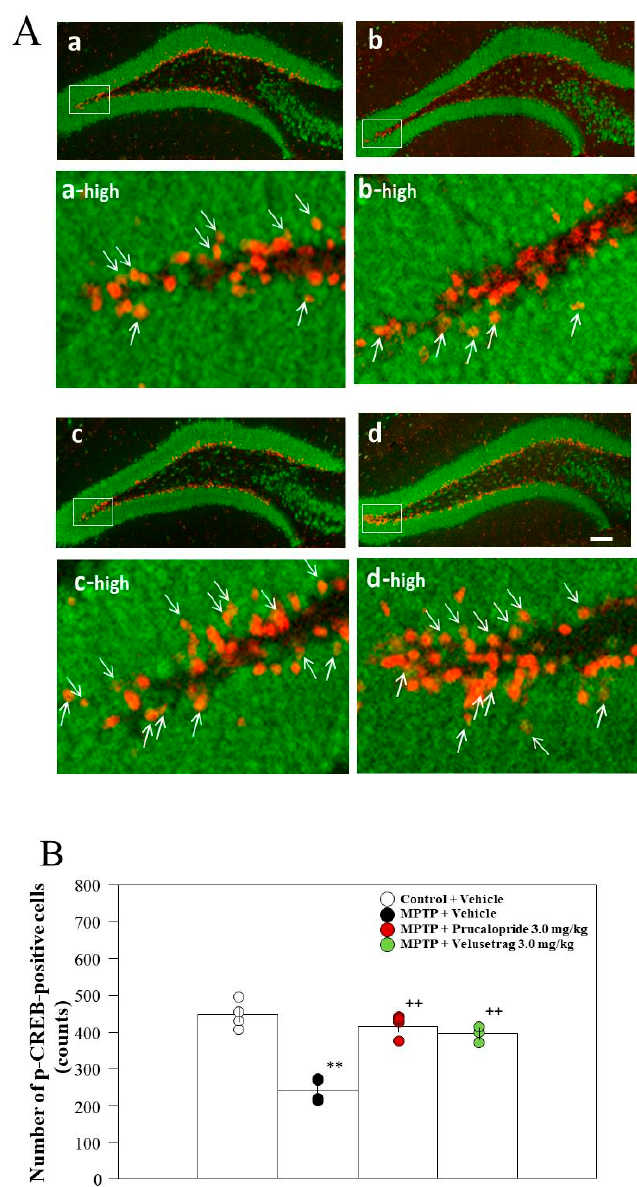
Figure 6. Analysis of the number of p-CREB-positive cells in the dentate gyrus (DG) of the hippocampus after extinction training. ( A ) Immunohistochemistry for p-CREB (red) and NeuN (green) in the DG after fear extinction. (a) Control + vehicle, (b) MPTP + vehicle, (c) MPTP + prucalopride 3.0 mg / kg, (d) MPTP + velusetrag 3.0 mg / kg. Scale bar = 100 µ m. The images of “a-high”, “b-high”, “c-high”, and “d-high” were partially expanded from the images of the white dotted box area in a, b, c, and d, respectively. Some p-CREB-positive cells co-localize with NeuN (yellowish red, indicated by white arrows). ( B ) The number of p-CREB-positive cells in the DG. The mean was calculated by averaging the number of p-CREB-positive cells counted from three 50- µ m sections (obtained from a position 1.82–2.02 mm posterior to the bregma). Data are expressed as the mean ± SEM; n = 3–4 per group. ** p < 0.01 vs. control + vehicle, ++ p < 0.01 vs. MPTP + vehicle (one-way ANOVA followed by Tukey’s post-hoc test).